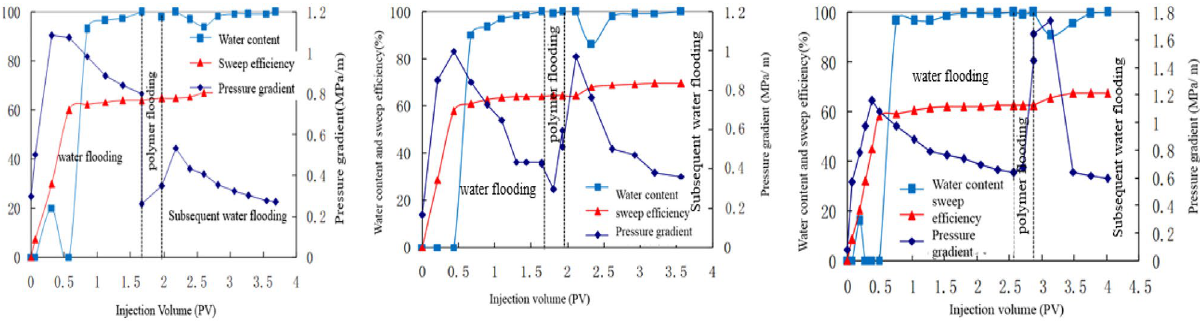
Fig. 10 Core flooding experiment results of 100 mg/L (left), 500 mg/L (middle), 1000 mg/L (right) of polymer 125VM